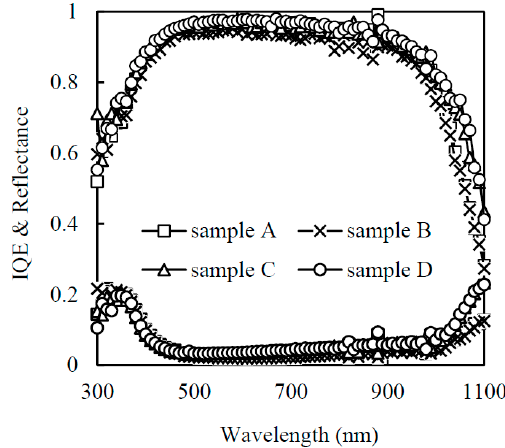
Figure 5. IQE (internal quantum efficiency) and reflectance for the PERCs deposited on Si wafers with different rear-side surface morphologies.